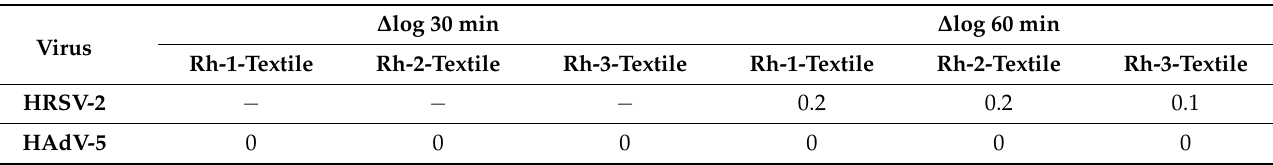
Table 3. Virucidal effect of new cotton fabrics dyed with rhodamine-peptides against human respiratory syncytial virus (HRSV-S2) and human adenovirus C serotype 5 (HAdV-5) after 30 min/60 min. Virus